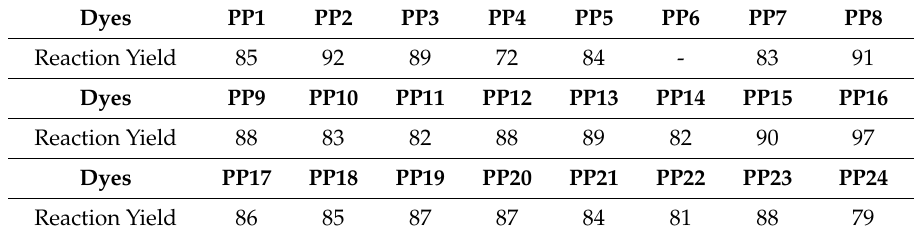
Table 1. Reaction yields obtained for the synthesis of PP1 – PP24 by Knoevenagel reactions. Dyes PP1 PP2 PP3 PP4 PP5 PP6 PP7 PP8 Reaction Yield 85 92 89 72 84 - 83 Dyes PP9 PP10 PP11 PP12 Reaction Yield 88 83